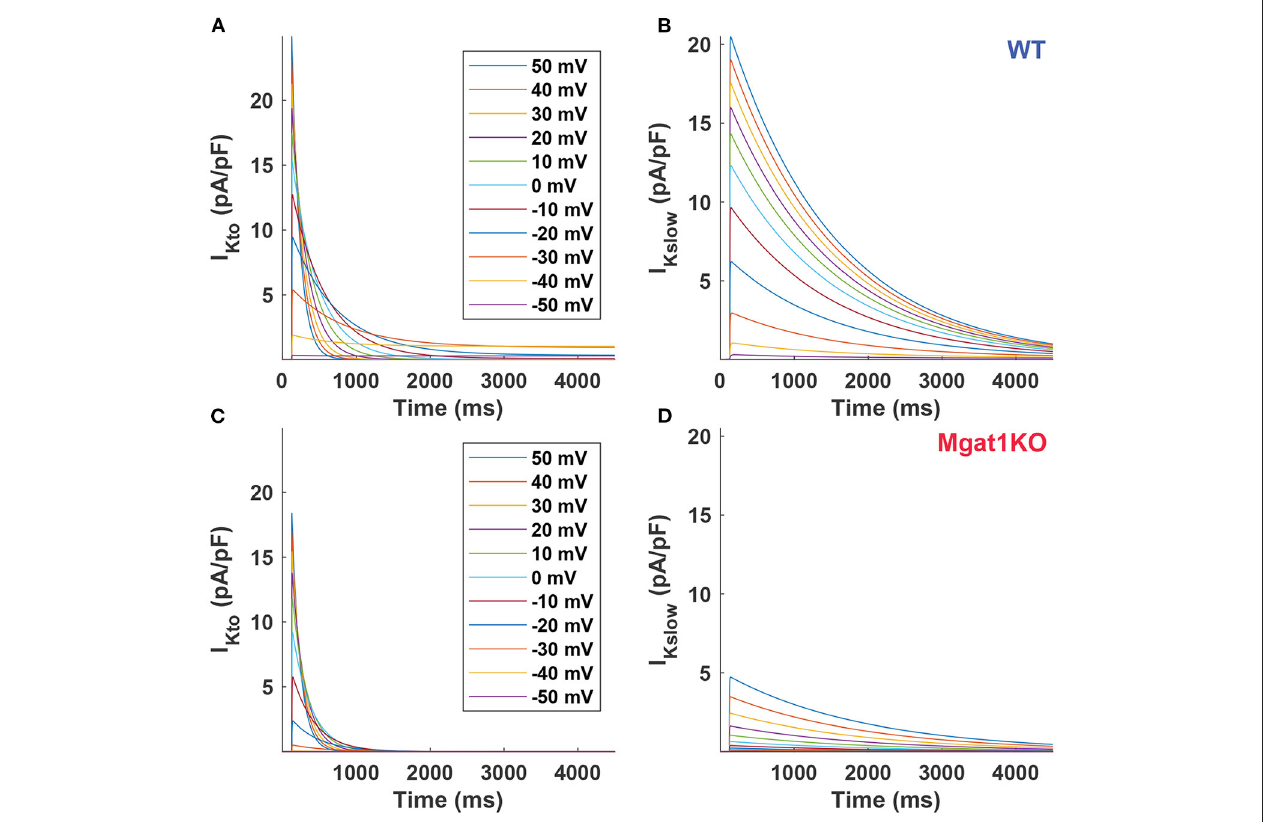
FIGURE 5 | Predicted current traces. (A) I Kto for WT. (B) I Kslow for WT. (C) I Kto for Mgat1KO. (D) I Kslow for Mgat1KO. Clamp voltages of 4.5 s were applied to from -50 to +50 mV by 10-mV increments from the holding potential -70 mV.